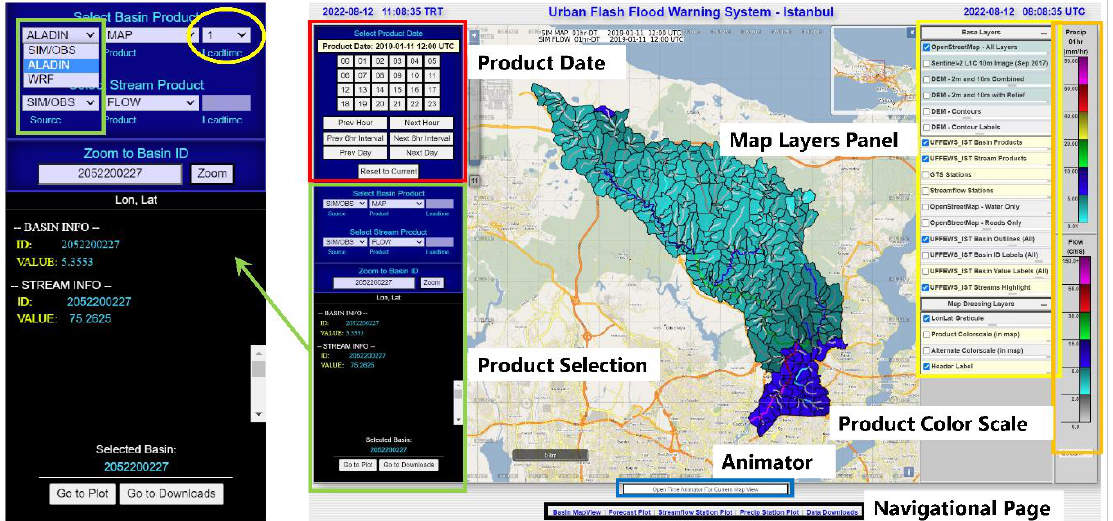
Figure 15. Interactive MapServer interface of the UFFWS-Istanbul.